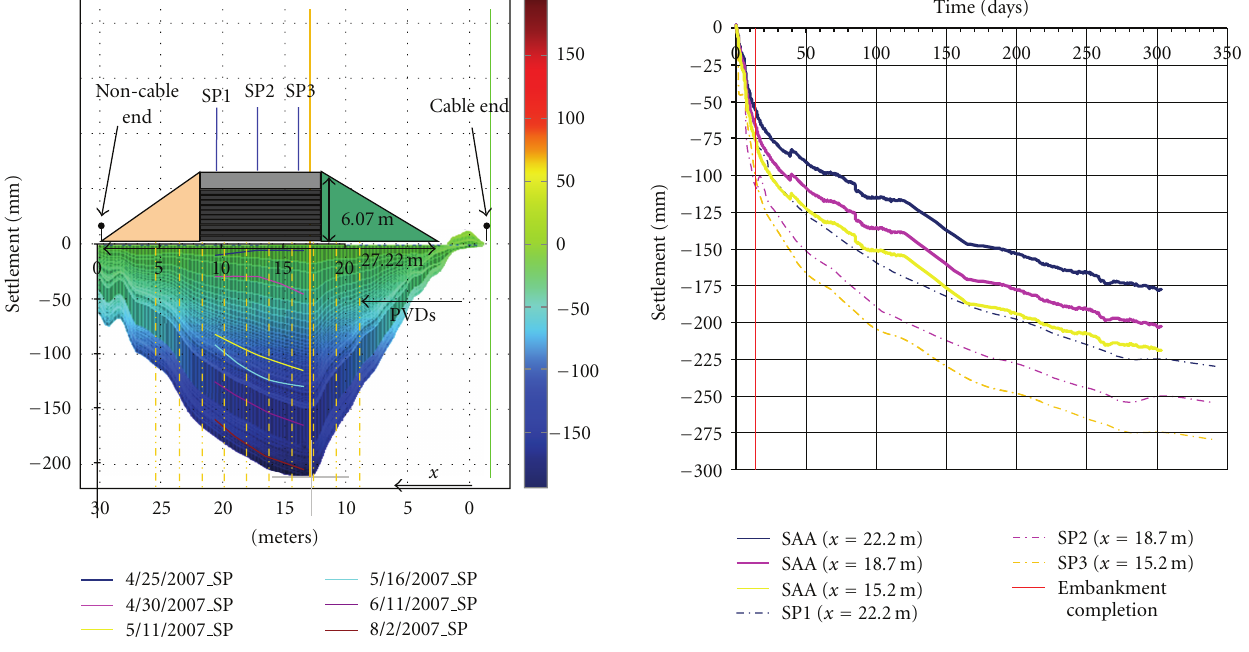
Figure 7: Settlement profile from horizontal SAA (contour plot) and nearest set of surface settlement plates (discrete lines).